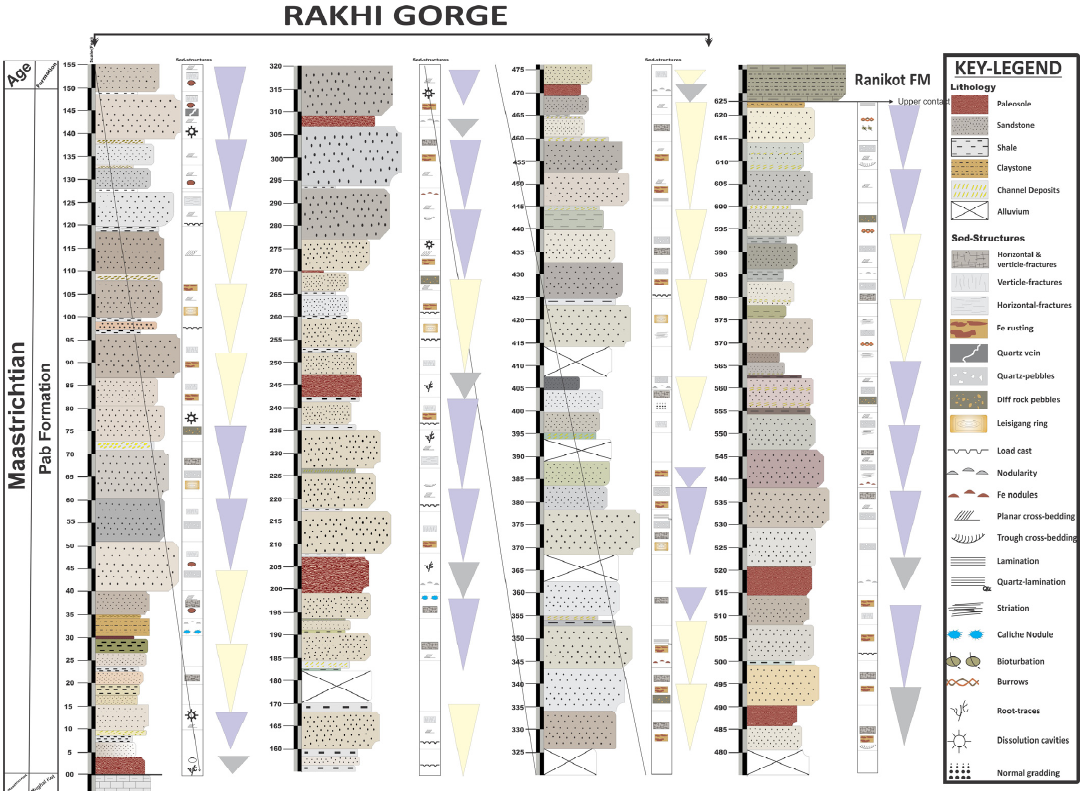
Figure 2. Showing the overall lithologic log of the Pab Formation in Eastern Sulaiman Ranges, the cyclic changes have been represented by the funnel shape with faded color representing fluvial and light color representing the deltaic sediments. The o ff -black color represents the development of a humid climate resulting in paleosol.